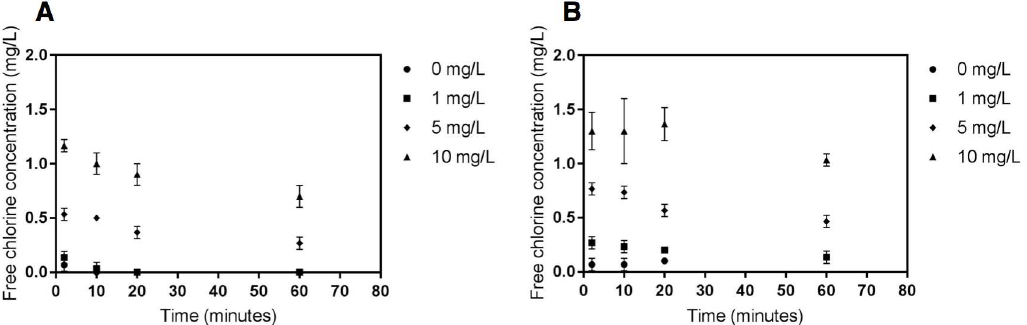
Fig 1. Free chlorine concentration in sterilized (gamma-irradiated) wastewater (A) and wastewater (B) over four time points (2, 10, 20 and 60 minutes) for initial doses of 0, 1, 5, and 10 mgL -1 sodium hypochlorite. Error bars represent the standard deviationcalculatedfrom three